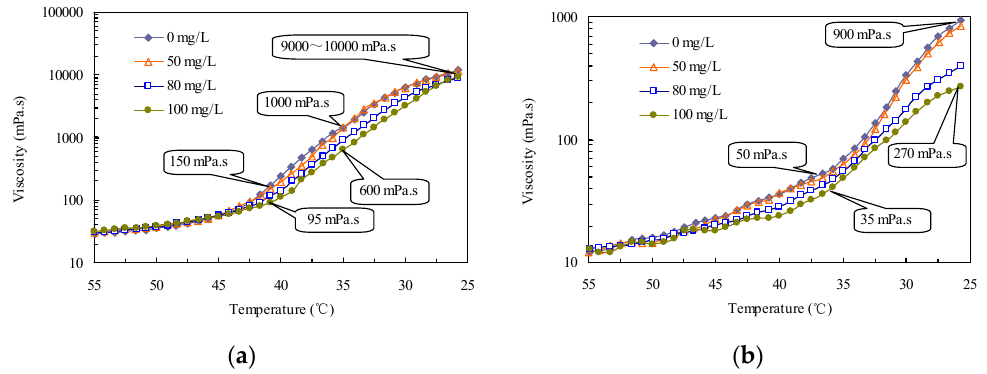
Figure 6. The viscosities of crude oil as a function of temperature before and after the drag-reducing surfactant addition: ( a ) highly viscous oil, ( b ) low viscous oil. Table 1. Pour point of the crudes before and after the drag-reducing surfactant